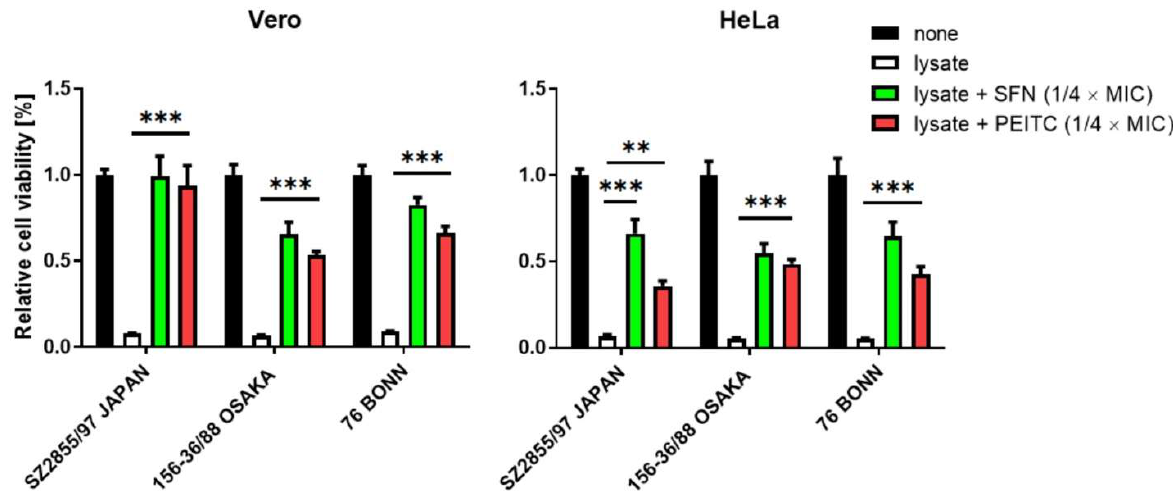
Figure 2. ITC reduces the toxicity of S. dysenteriae lysates. The effect of SFN on viability of HeLa and Vero cells treated with S. dysenteriae lysate was assessed after 74 h in the absence or presence of SFN at concentrations indicated. Untreated culture was used as a negative control (black bar) and a culture treated with bacterial lysate was used as a positive control (white bar). SFN (green bar) and PEITC (red bar) treated groups were assessed against positive control using Student’s t -test. Statistical significance is marked with asterisks: *** p <0.001; ** p <0.01.